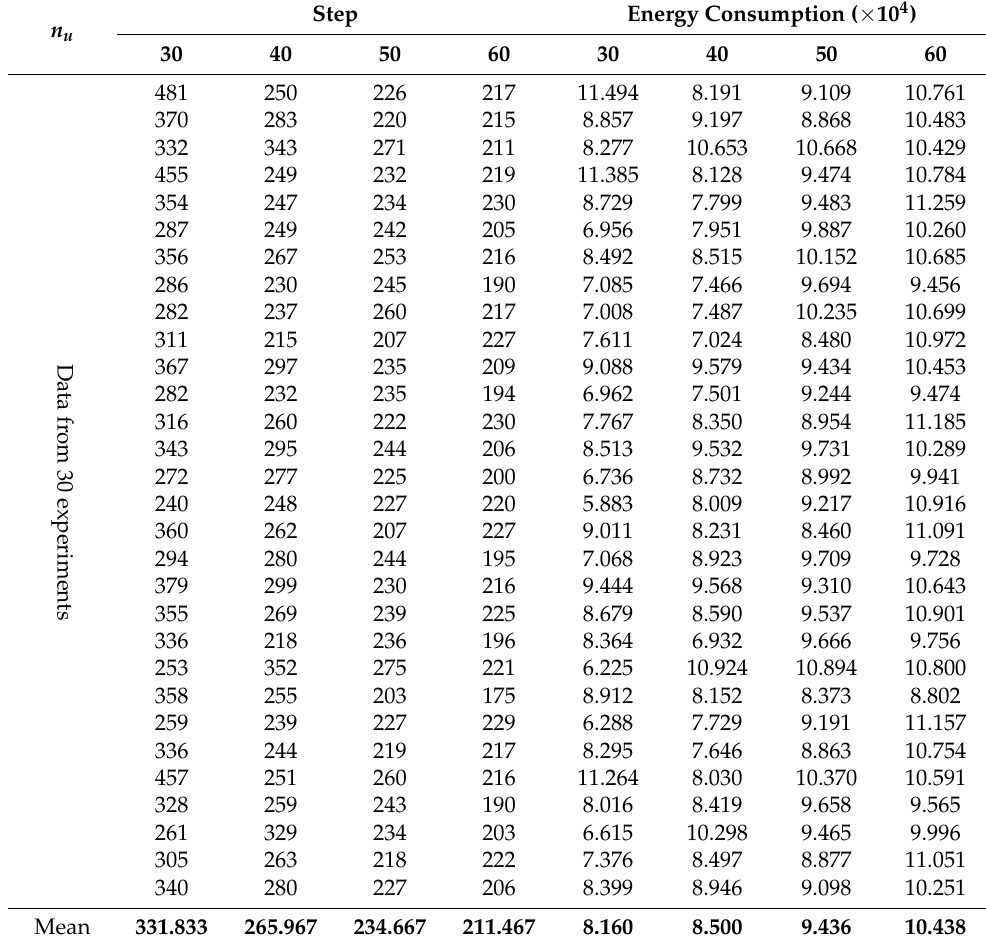
Table 3. Target n T = 10 and mountain slope less than or equal to β : the number of steps and energy consumption required for the robots to complete the task